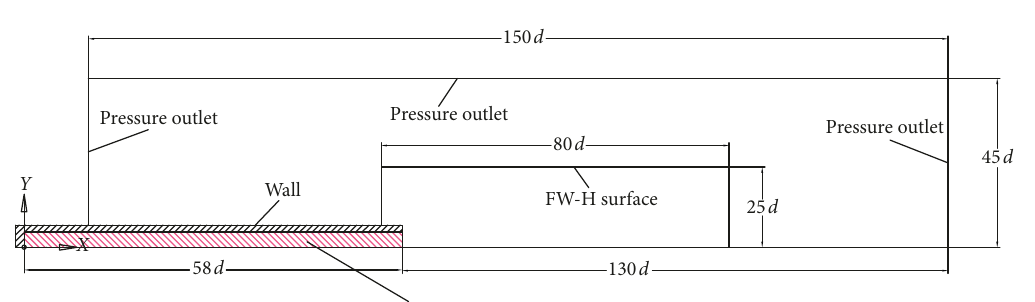
Figure 11: Initial condition.